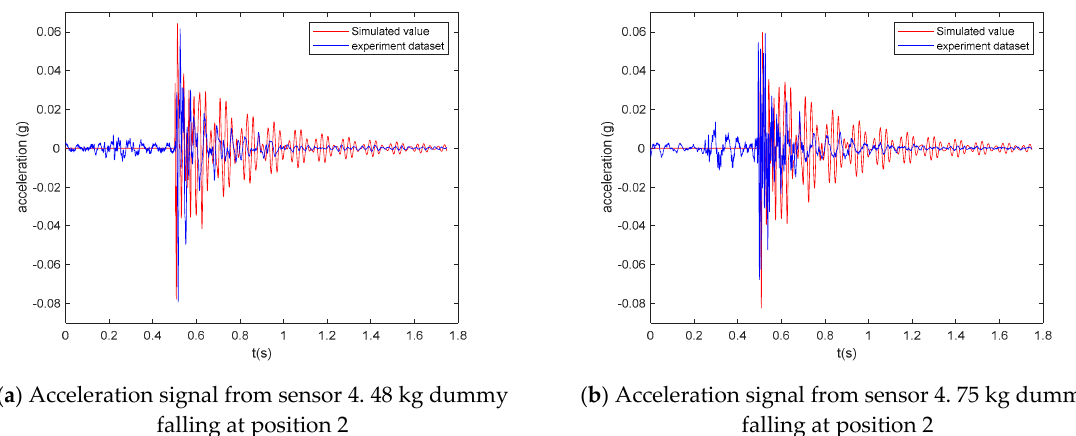
Figure 17. F inite element (FE) model of experimental laboratory floor.